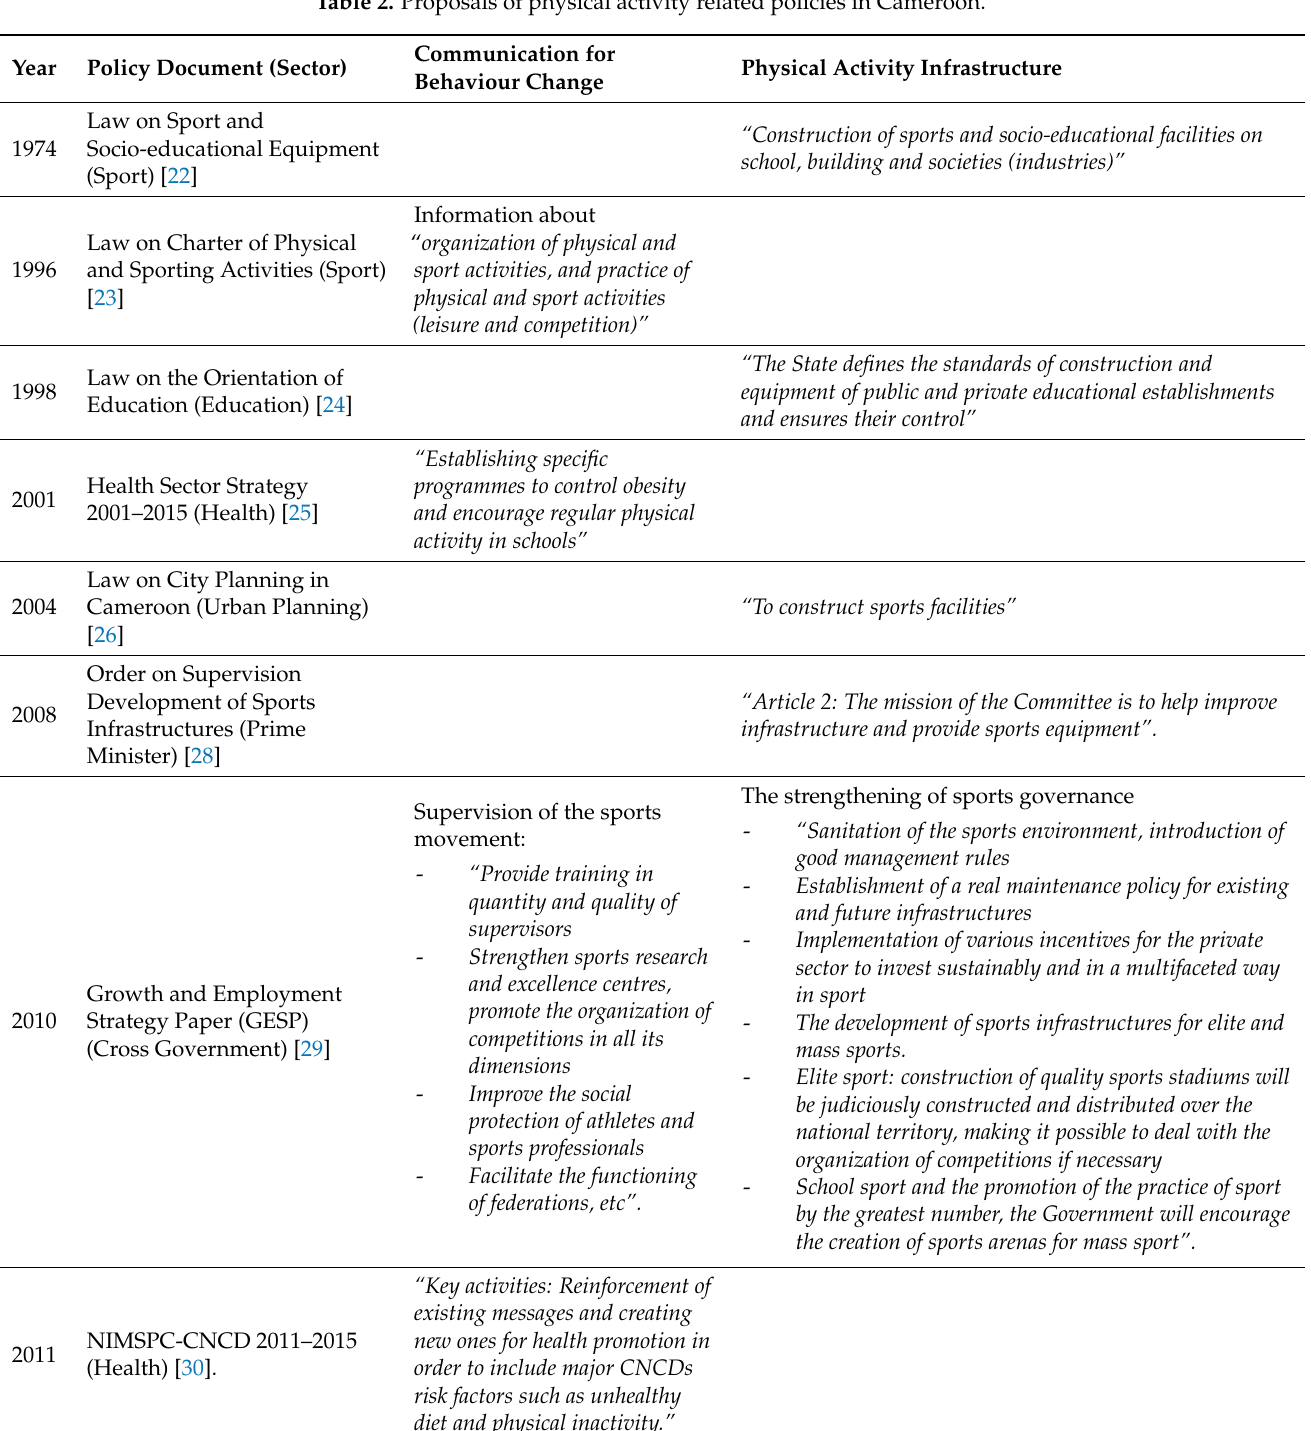
Table 2. Proposals of physical activity related policies in